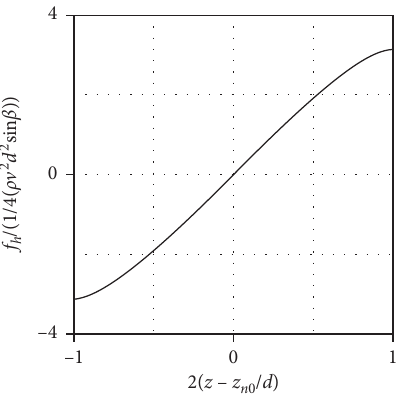
Figure 6: Axial force on the bucket due to difference between nozzle and bucket centerlines.